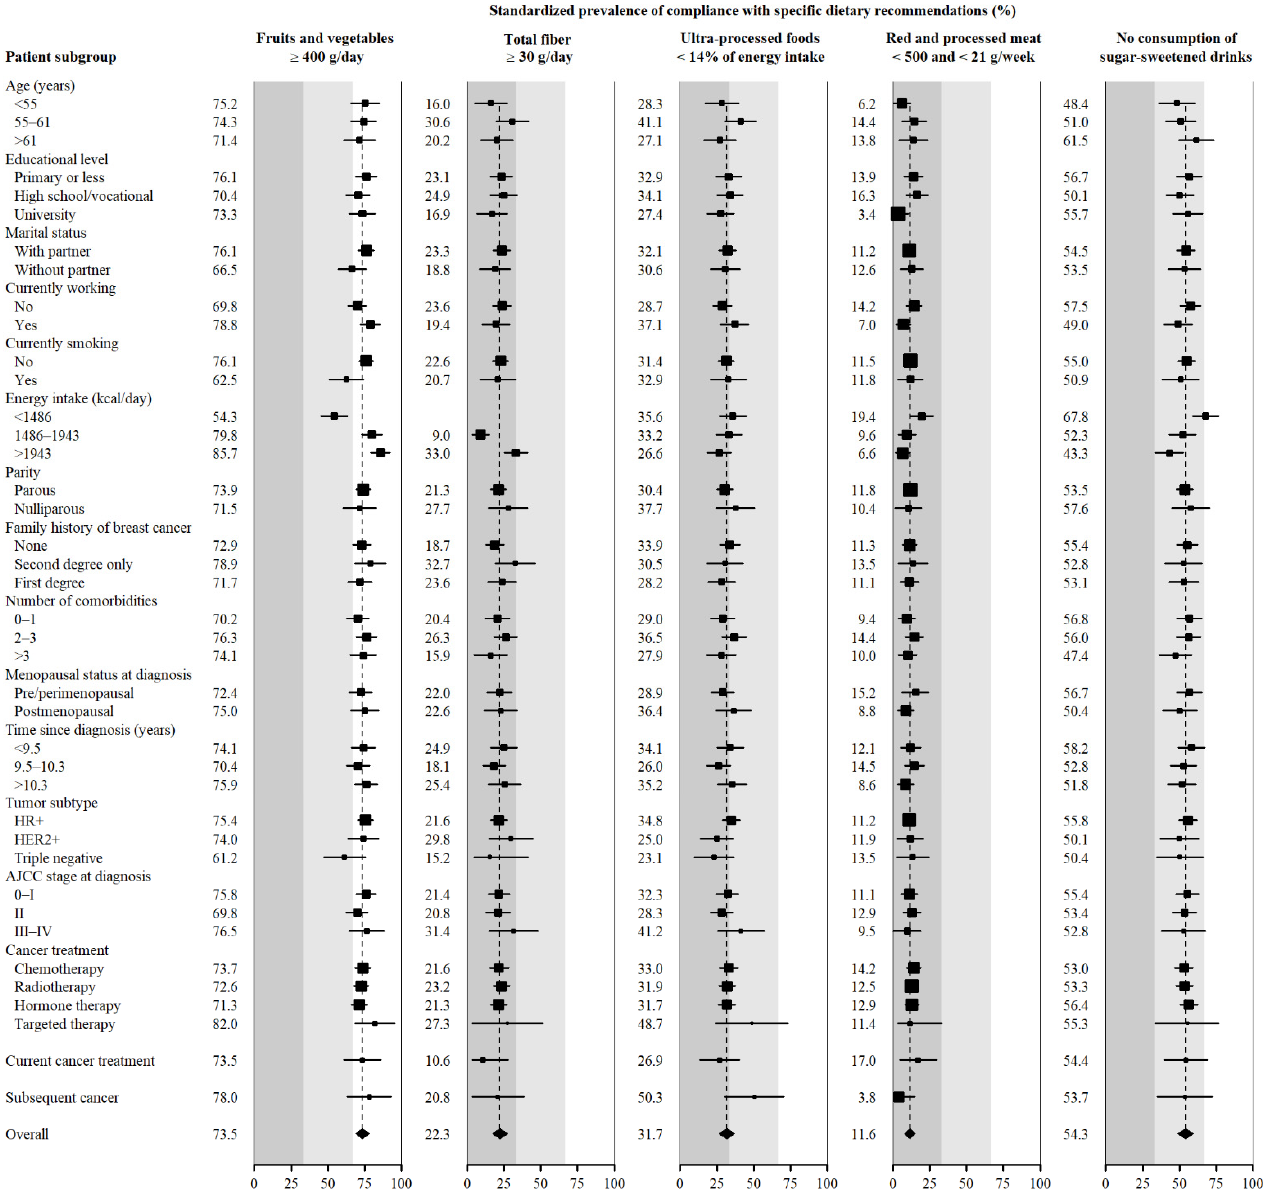
Figure 2. Standardised prevalence of high compliance with specific dietary recommendations by sociodemographic and clinical characteristics of breast cancer survivors (%). Standardised prevalence (95% CI) to the overall distribution of age, recruiting region, educational level, marital status, currently working, currently smoking, caloric intake, parity, family history of breast cancer, number